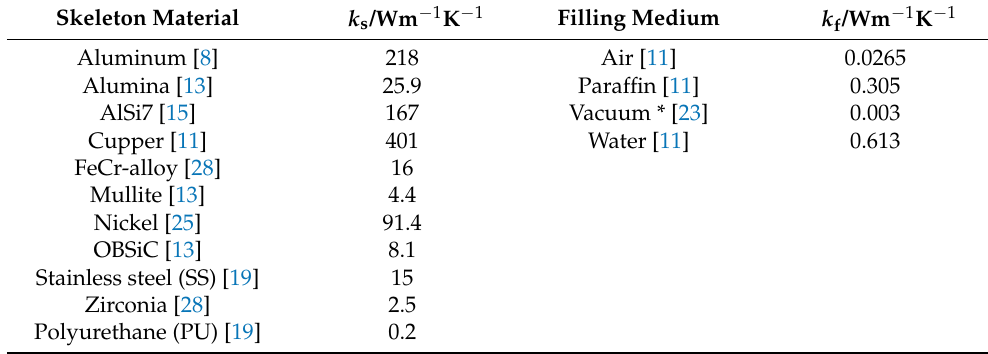
Table 2. Thermal conductivities of filling media and skeleton bulk materials (* average value [23]). Skeleton Material